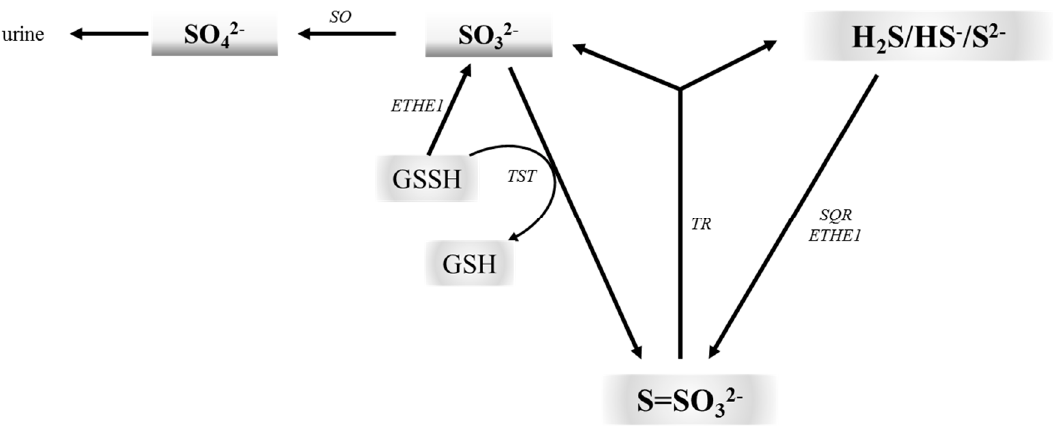
Figure 2. The thiosulfate cycle links aerobic and anaerobic metabolism of cysteine. H 2 S can be oxidized by SQR and ETHE1 to thiosulfate. Sulfane sulfur can be transferred from GSSH to sulfite leading to thiosulfate formation. Sulfite can also be further oxidized to sulfate by SO. On the other hand, thiosulfate may be converted back to H 2 S and sulfite by TR. SO: sulfite oxidase; ETHE1: ethylmalonic encephalopathy protein 1; TST: rhodanese; TR: thiosulfate reductase; SQR: sulfide:quinone oxidoreductase.